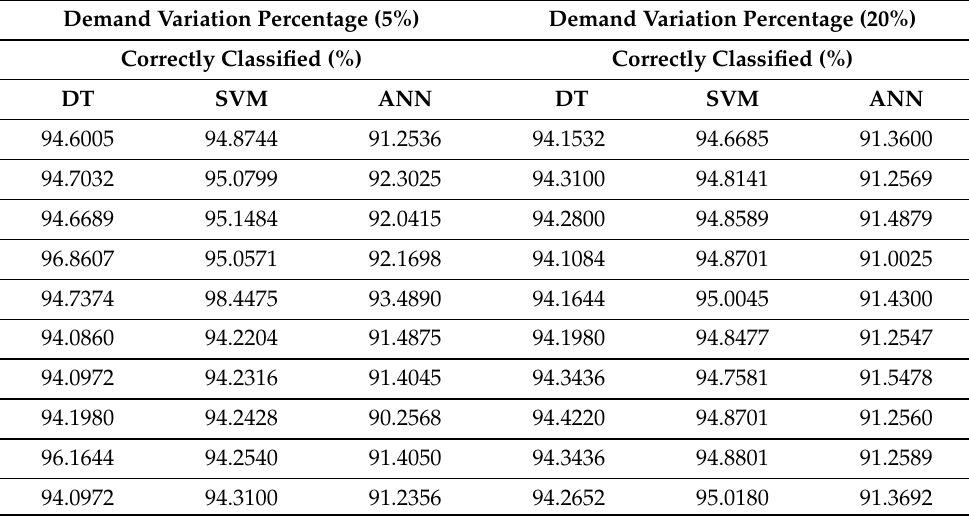
Table 2. Classification percentage using